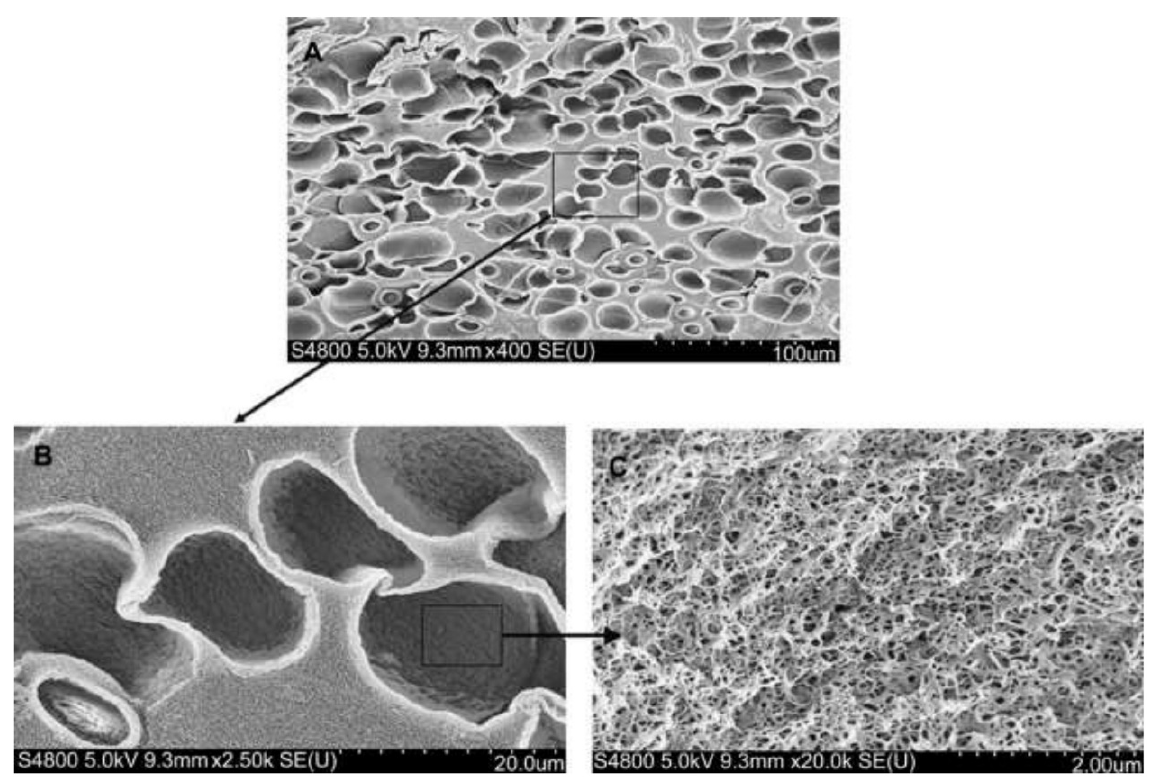
Figure 2. SEM images of the PU scaffold made by inkjet printing. A and B show the primary structures. C shows the secondary structure [37].